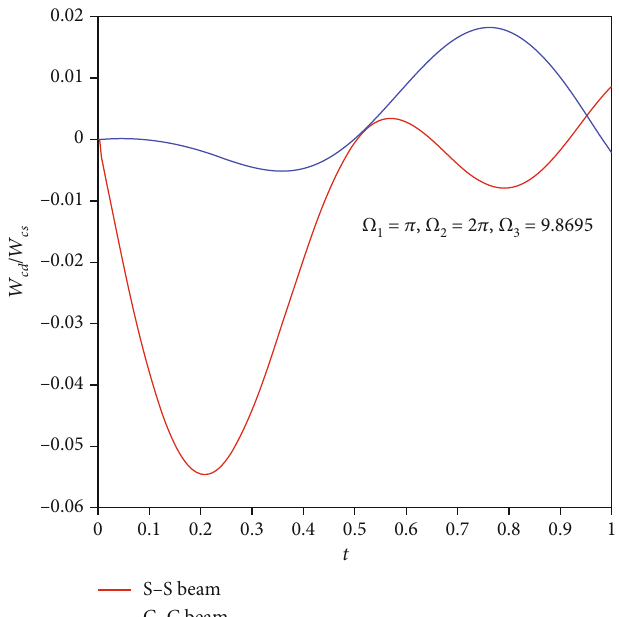
Figure 9: Time response for normalized central de fl ection of S-S and C-C beam excited by three actuators with di ff erent harmonics ( Ω 1 , Ω 2 , Ω 3